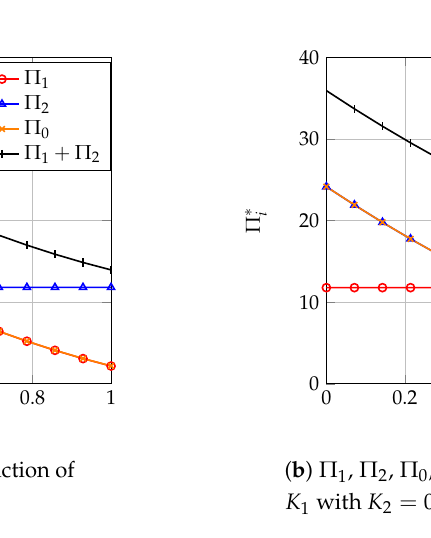
Figure 11. MNOs equilibrium profits.